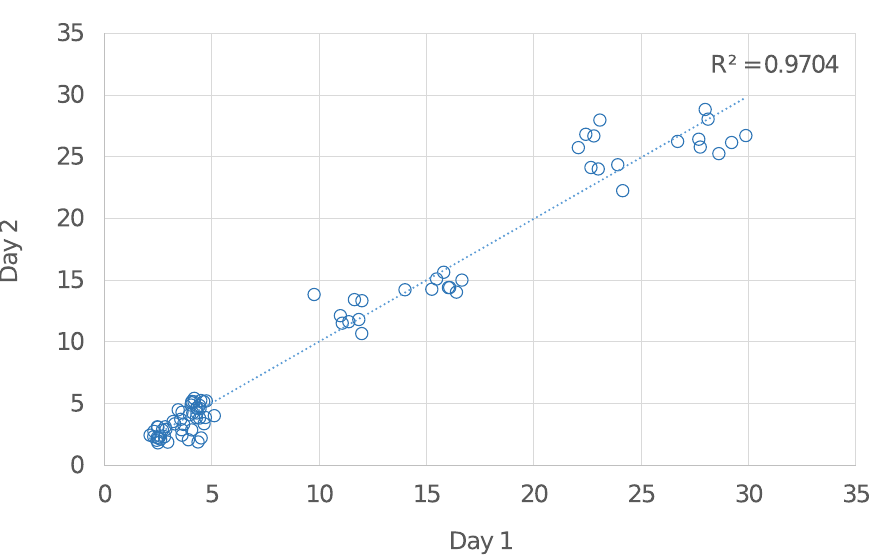
Fig 2. Linear regression plot comparing RA values of ten representative O -glycan structures. Glycans from eight independent BSM type I-S samples were released, purified, permethylated and analysed by MALDI-TOF-MS in two separate days (eight samples on day 1 versus eight samples on day 2) to assess interday variation. The R 2 value = 0.97, which is a value close to 1 and therefore shows a good correlation and a low variation between the two data sets.